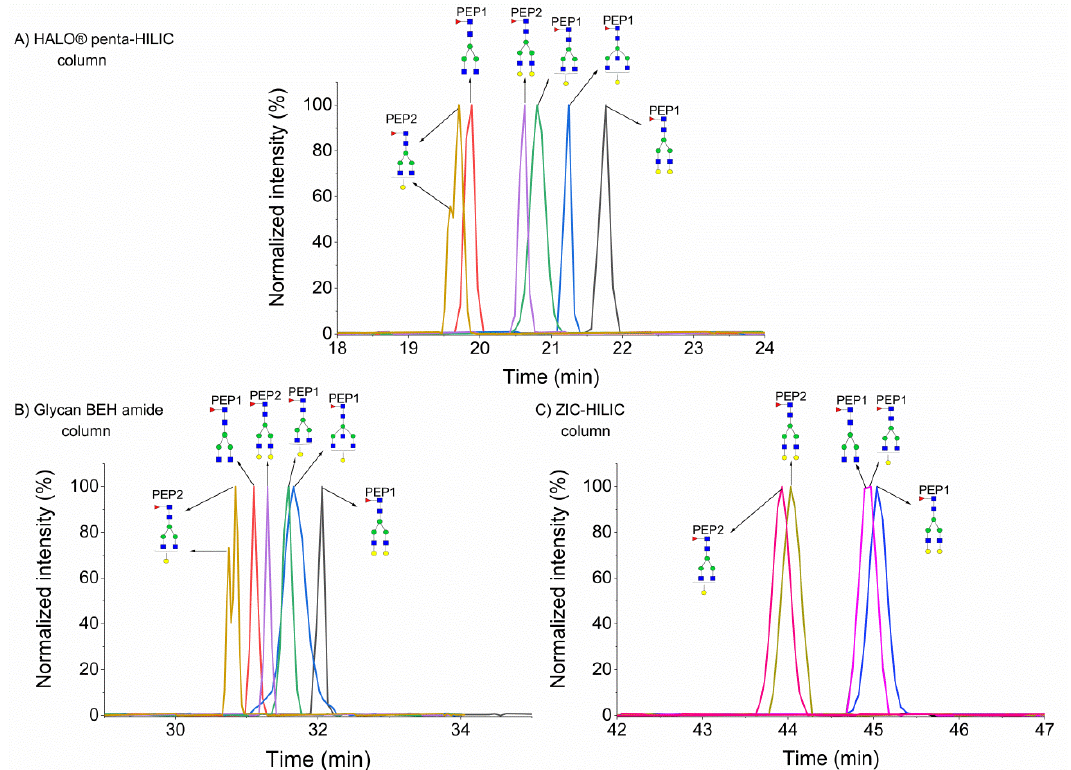
Figure 2. Separation of glycopeptides of IgG in HALO ® penta-HILIC ( A ), Glycan BEH amide ( B ), and ZIC-HILIC ( C ) columns. PEP1 refers to EEQYN 180 STYR and PEP2 to EEQFN 176 STFR.